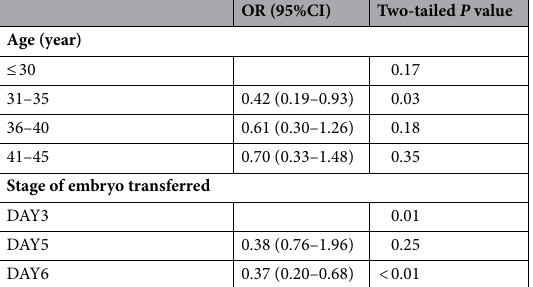
Table 4. Binary logistic regression of influencing factors on pregnancy rates in the two groups.